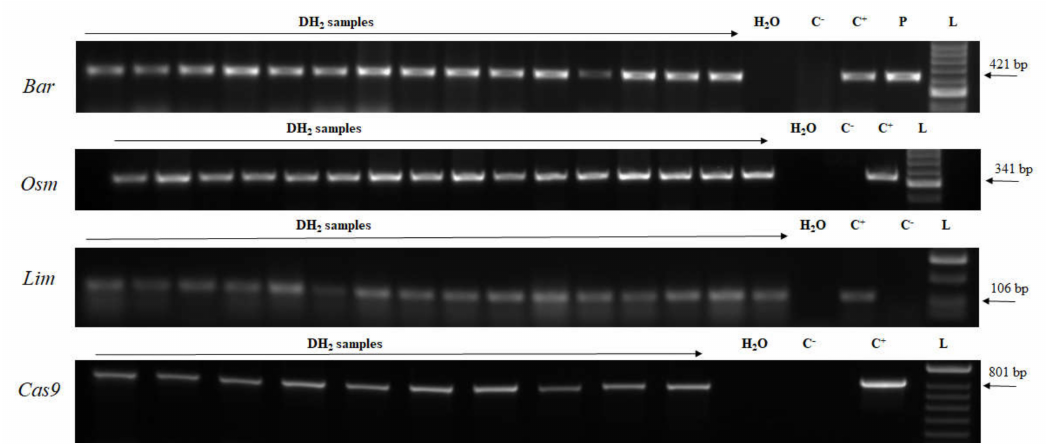
Figure 6. Detection of the transgenes in DH2 generation transgenic plants. L—DNA